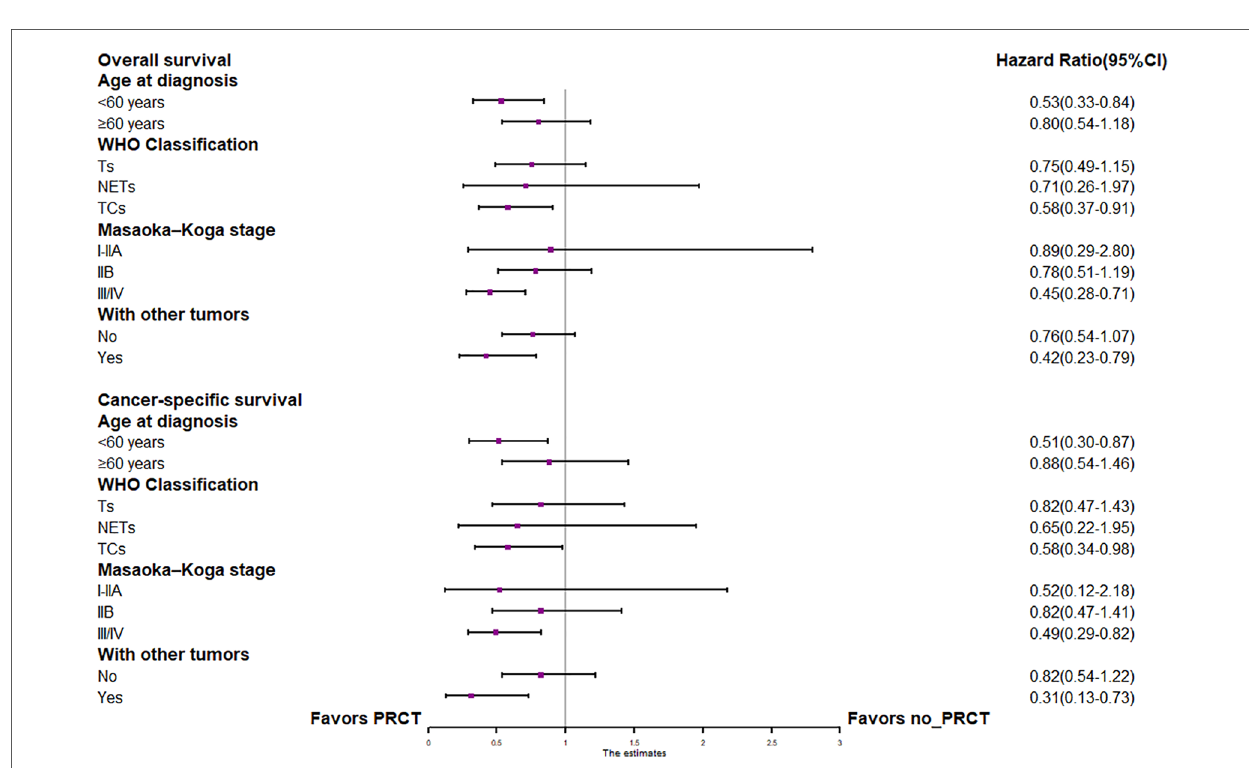
FIGURE 7 Forest plots of OS and CSS for subgroup analysis based on different grouping